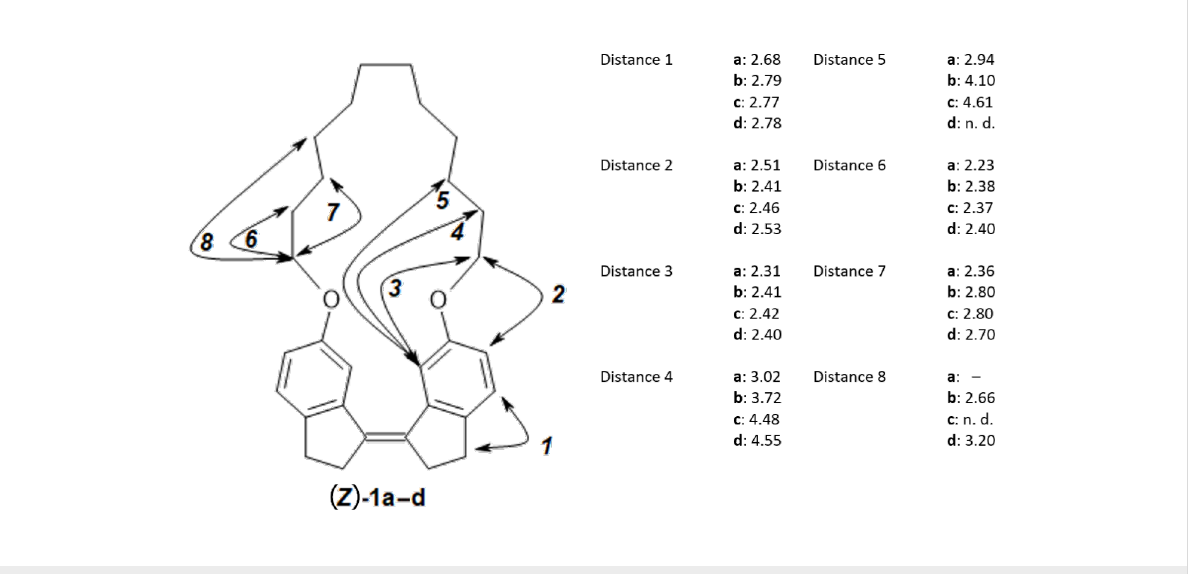
Figure 7: Distances derived from NOE buildup experiments. Distances between pairs of protons or groups of protons attached to the indicated carbons are designated as distance 1 through 8. n.d.: NOE cross peak not detectable. – : distance does not exist.